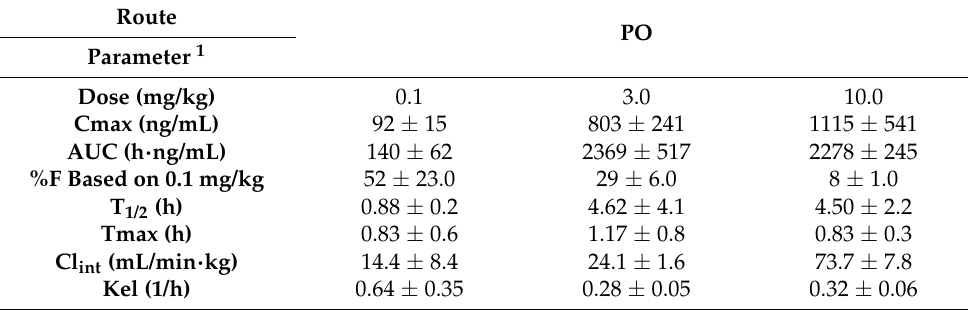
Table 3. Summary of key PK parameters after oral dosing in